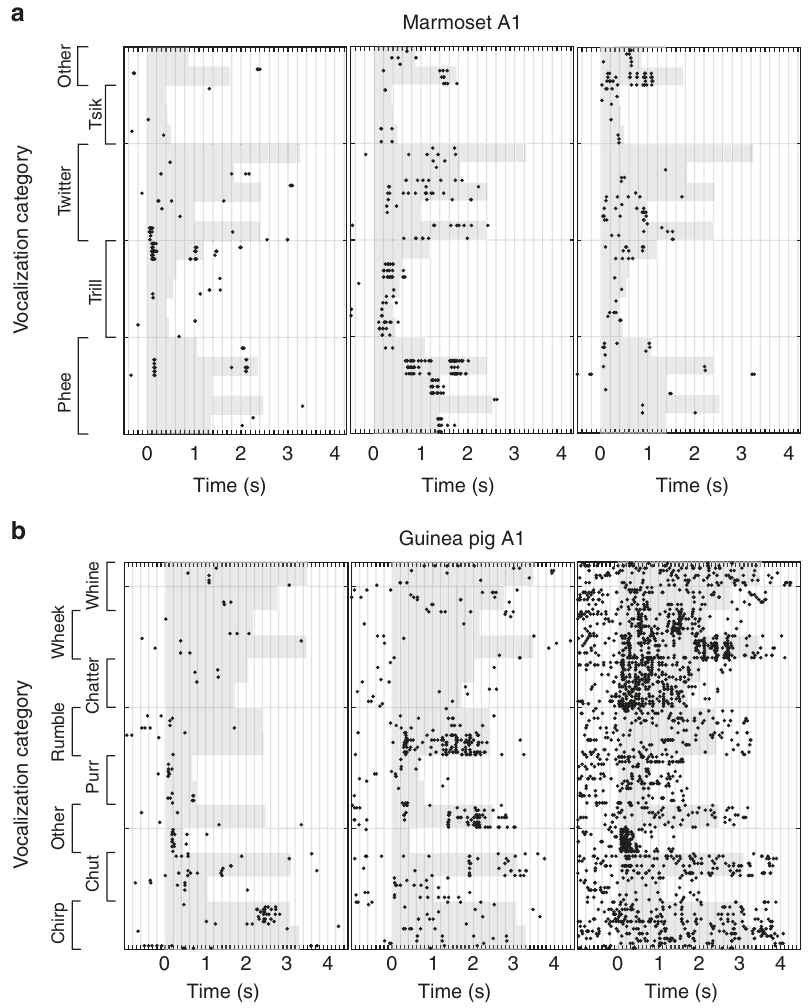
Fig. 9 Feature selectivity in cortical neurons. a Spike rasters of three single units from marmoset A1 responding to marmoset call stimuli. Black dots correspond to spikes; gray shading corresponds to stimulus duration (different calls have different lengths). Note that spikes occur at speci fi c times, and in response to 2 or 3 call types, suggesting that the neurons are responding to smaller features within these calls. b Spike rasters of three single units